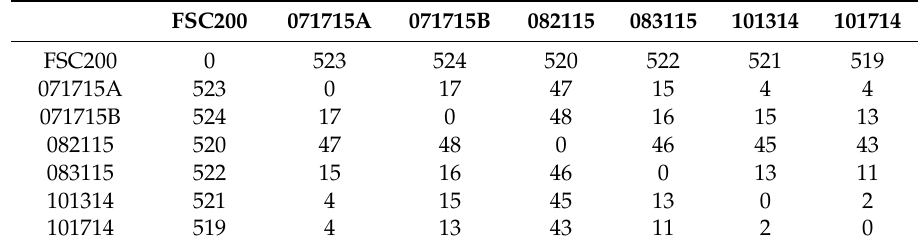
Table 2. Single nucleotide polymorphism (SNP) pairwise matrix for the core genome from the six F. tularensis type B strains isolated from the same region in the United States within a one-year period relative to each other and to the prototype type B strain FSC200 1,2